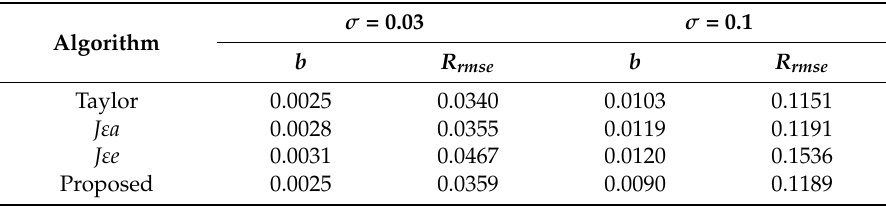
Table 2. Average b and R rmse for the four algorithms. Unit: